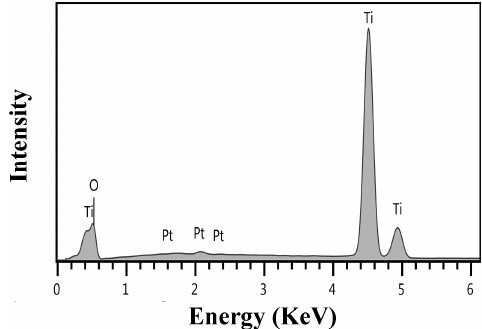
Figure 3. EDS spectra for heat treatment (to 900 °C) and cooling to room temperature for nanotubes of anodized titania.